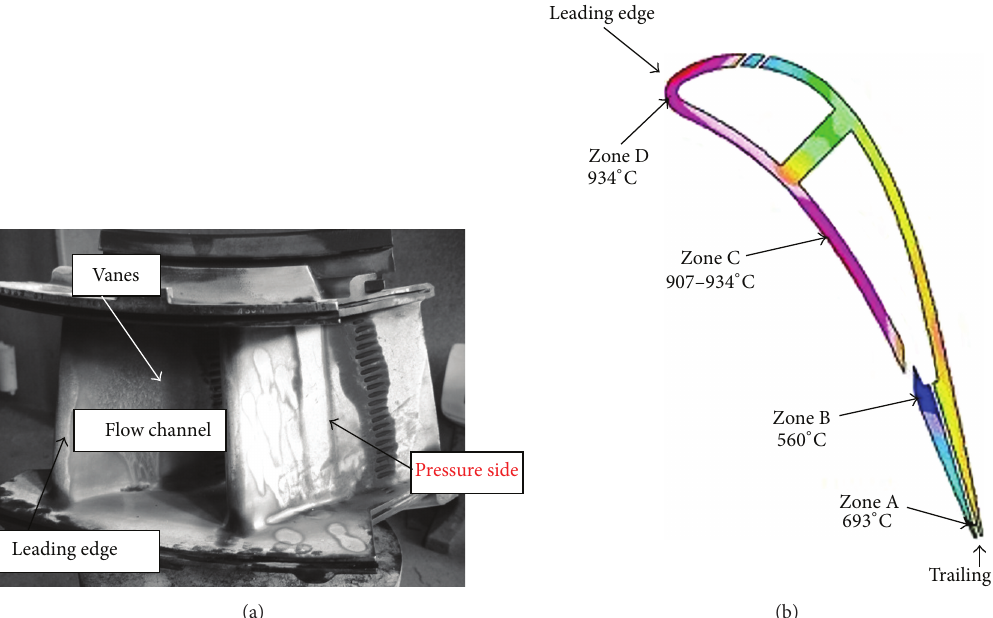
Figure 3: (a) General view of the nozzle vane. (b) Analysis regions and internal temperature distribution on the nozzle vane transversal section in the cutting plane at 50% height (section of maximum temperature).